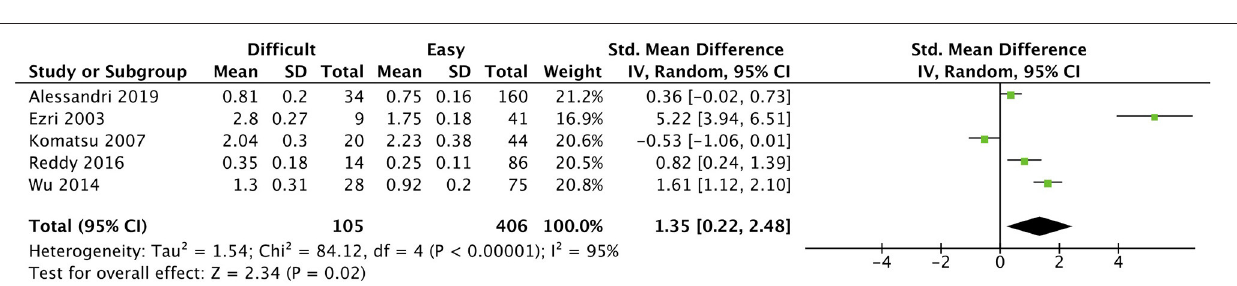
FIGURE 4 | Skin to anterior commissure of vocal cords distance forest plot comparing difficult and easy laryngoscopy groups.